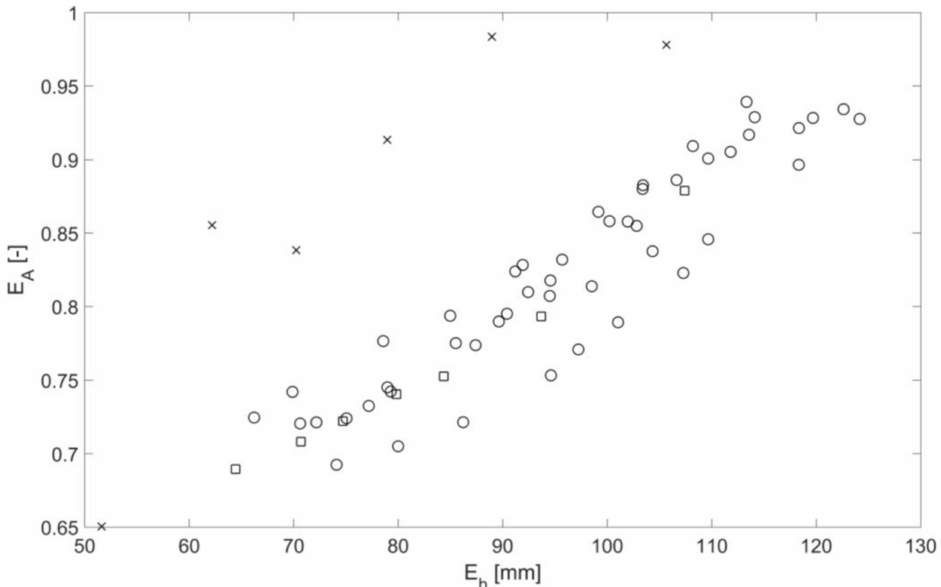
Figure 10. Continuous sound pressure wave envelope as a function of mean flow depth for three bed roughness types: clean pipe (cross), pipe with mesh (squares), pipe with spheres